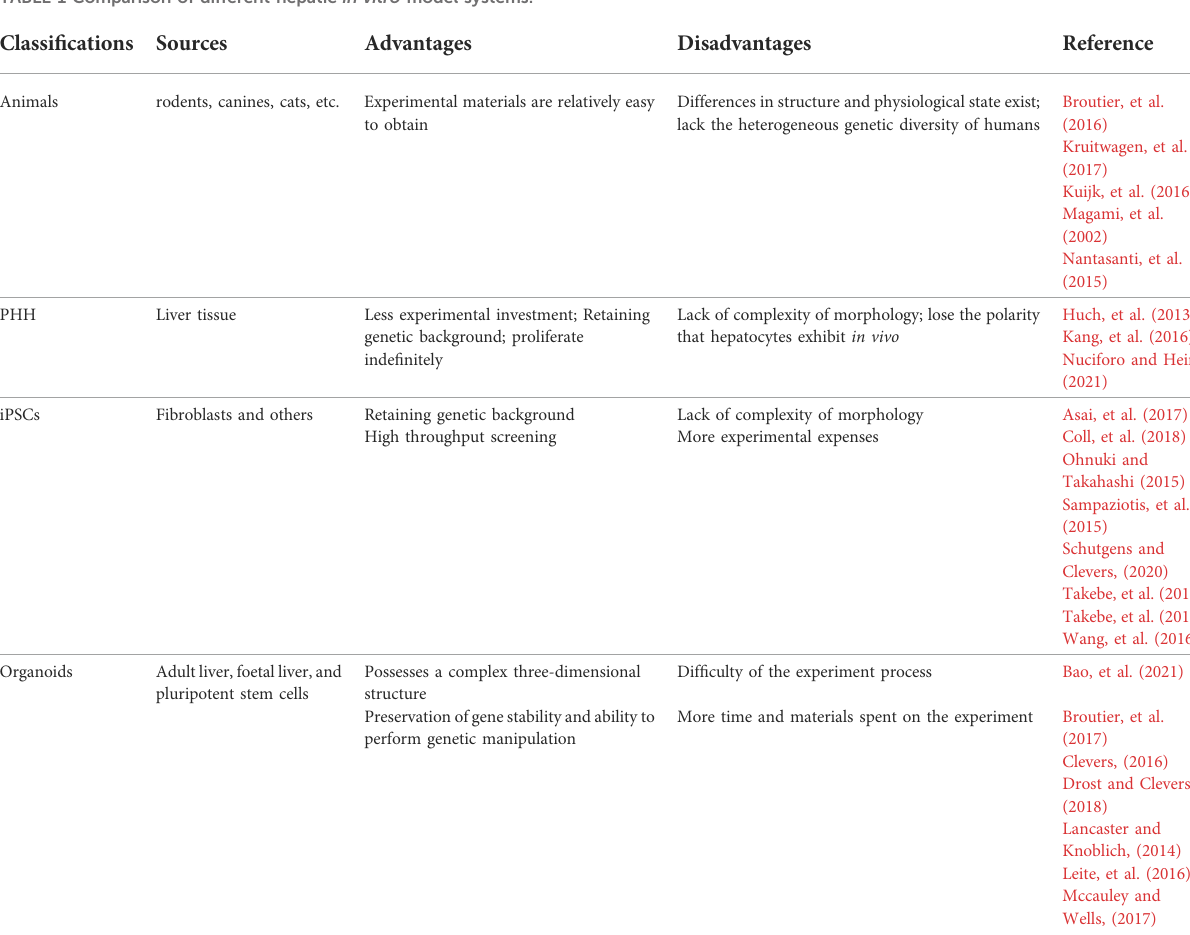
TABLE 1 Comparison of different hepatic in vitro model